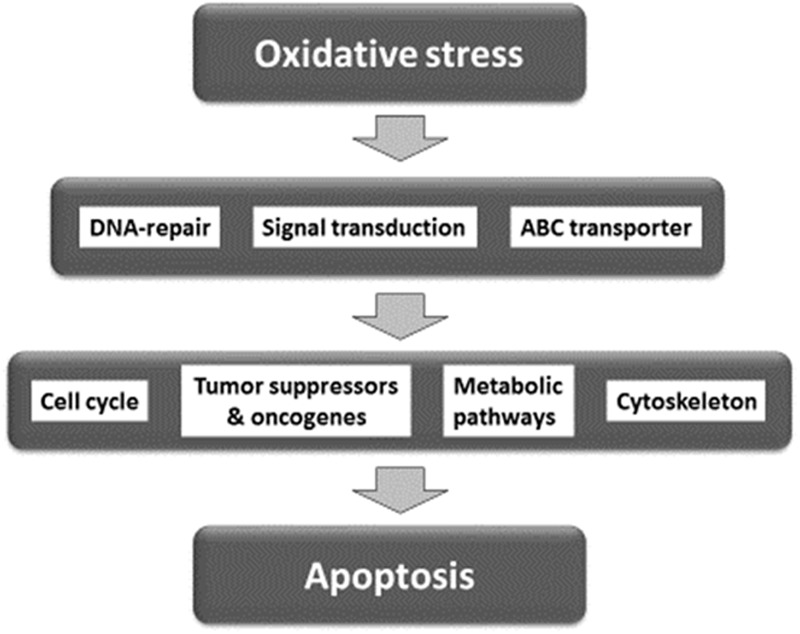
Synopsis of mechanisms involved in the activity of As2O3 against cancer cells.